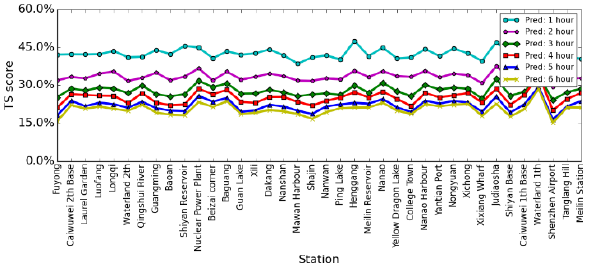
Figure 6.TS scores of 2 hours time scale SVM for future different hours rainfall prediction